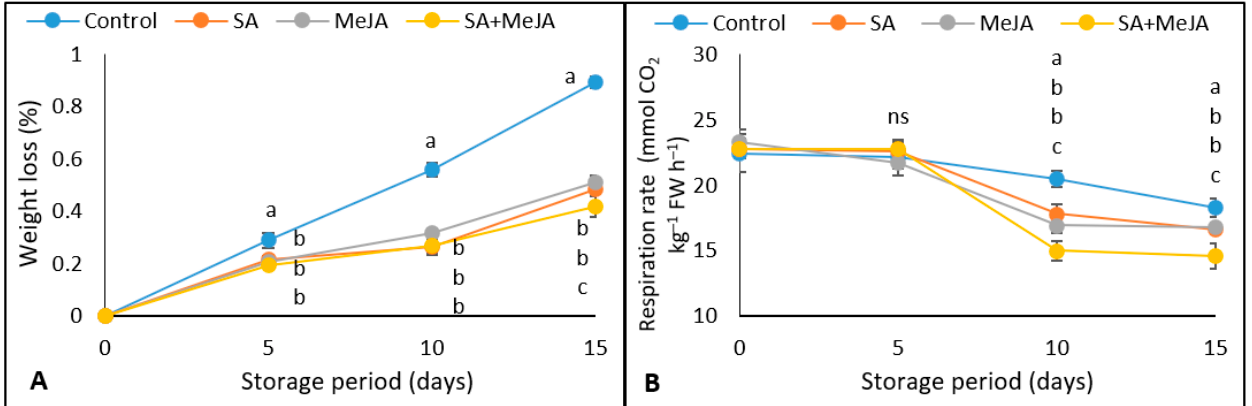
Figure 2. Effects of salicylic acid (SA), methyl jasmonate (MeJA), and their combination postharvest treatments on ( A ) weight loss and ( B ) respiration rate of pomegranate arils stored at 5 °C for 15 days. The presented data are the mean of three replicates ± standard error. Different letters present significant differences between treatments at the same storage point according to Duncan test at p < 0.05.